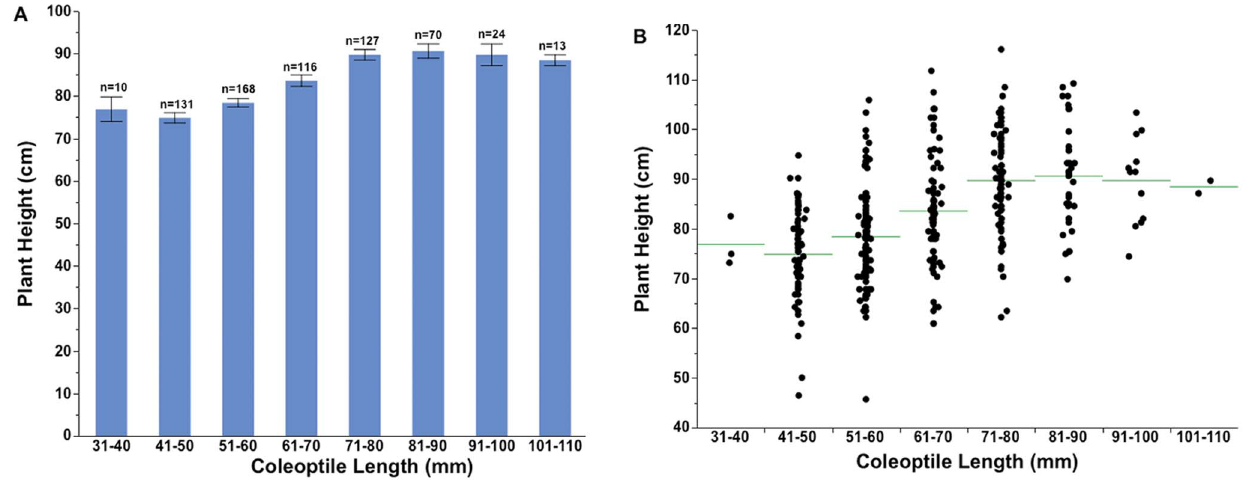
Figure 7. Mean (A) and range variation (B) in plant height at maturity in different coleoptile length classes of the world wheat collection. The bars are the standard error of the mean. The sample size (n) of each coleoptile class is provided above the data bars. The horizontal line represents the mean in each coleoptile class (B).